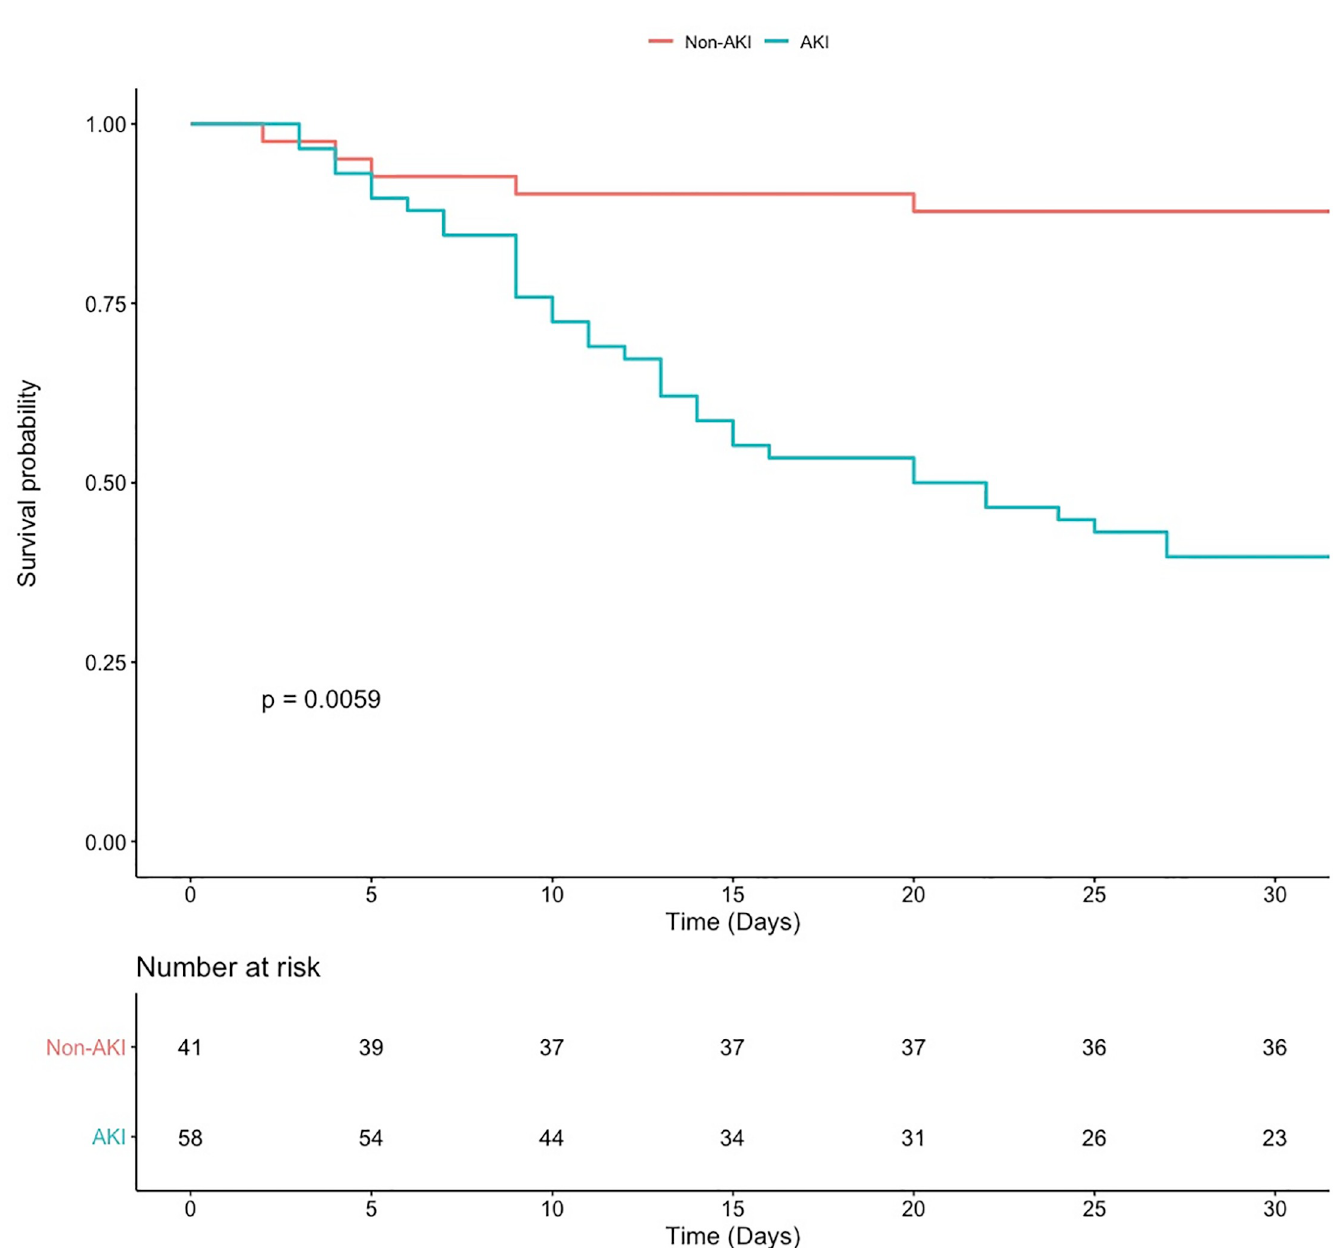
Fig 2. Kaplan-Meier survival curves. Time to death for the AKI group (blue line), and the non-AKI group (red line) during a follow-up period of 30 days. Time 0 corresponded to hospital admission. p = 0.01. Lymphocytes were decreased in the AKI group: 0.7 10x 3 mm 3 (IQR, 0.5–1) compared to the non-AKI group: 0.9 10x 3 mm 3 (IQR, 0.8–1.33, p = 0.01; Table 2). On admission, 82.8% had a positive result for SARS-CoV-2-rRT-PCR, but all patients had a positive result when the test was performed for the third time. Sixty-five patients (64.3%) required IMV. The median positive end-expiratory pressure (PEEP) level was 11.5 cm H (SD ± 2.4); and 28 required prone ventilation due to refractory hypoxemia. Forty-nine patients